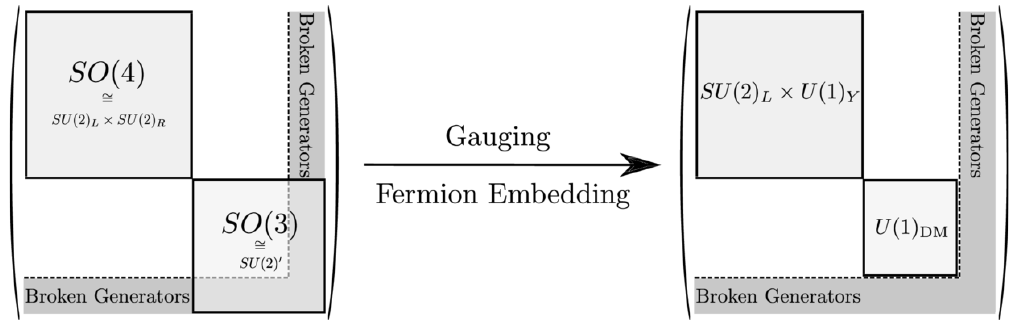
Figure 1 . Schematic overview of the SO(7) algebra. In the left drawing the structure of the SU(2) L (cid:2) SU(2) R (cid:2) SU(2) 0 subgroup is displayed, whereas the right drawing shows the